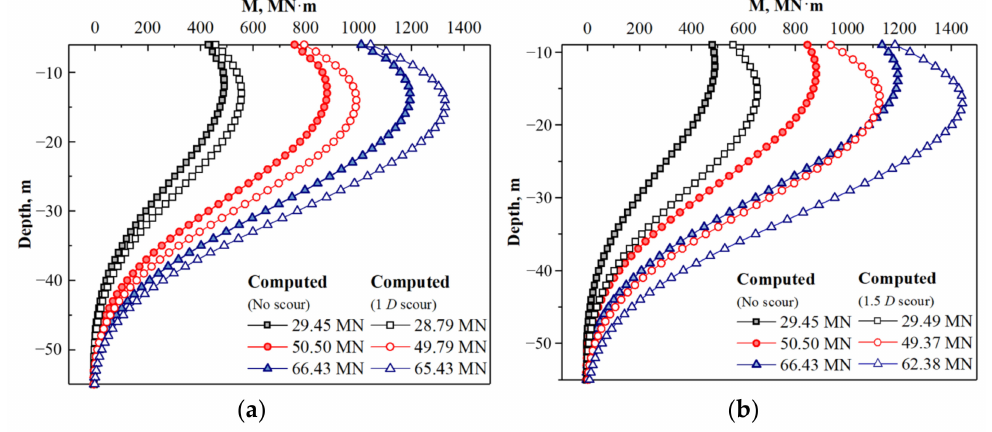
Figure 5. Comparison of pile deflection before and after scouring; ( a ) S d 1 = 1 D ( 6 m ) ; ( b ) S d 2 = 1.5 D ( 9 m )